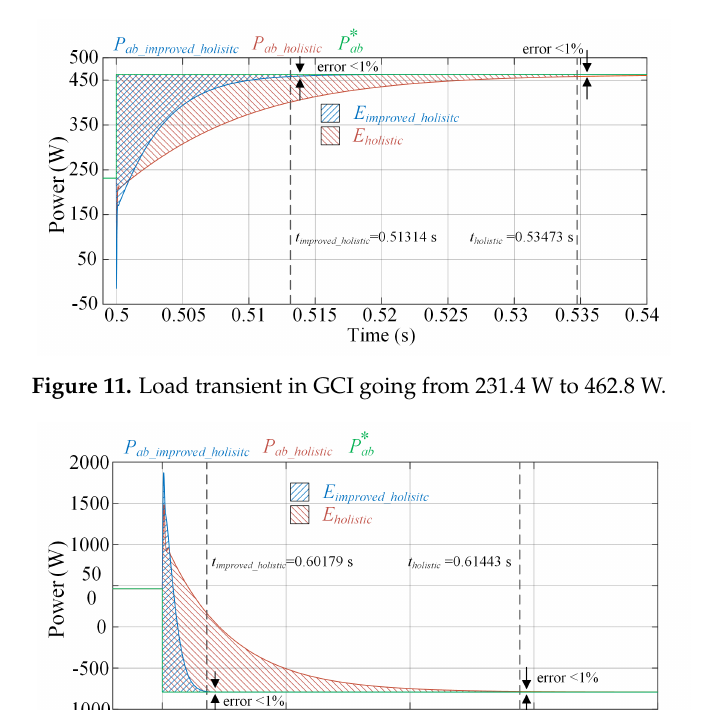
Figure 10. Current step in GCI going from 102.8 W to 231.4 W.